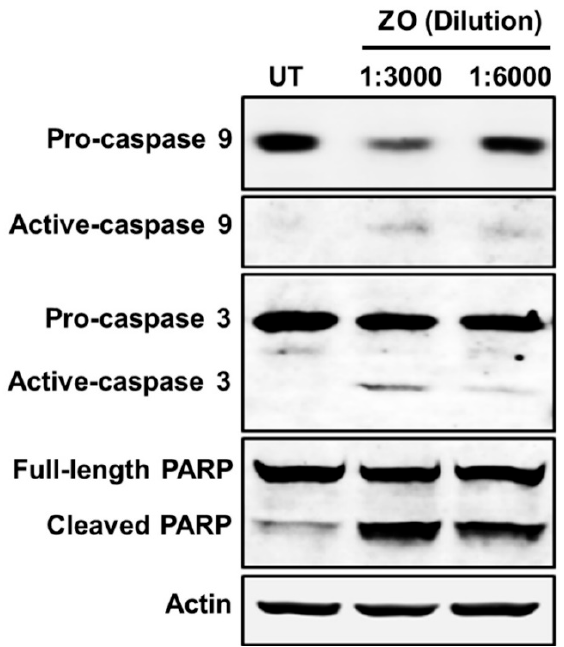
Figure 4. Western blot analysis detecting apoptosis signaling markers, including caspase 9, caspase 3, and PARP in HeLa cells treated with ZO essential oil at 1:3000 and 1:6000 dilutions for 24